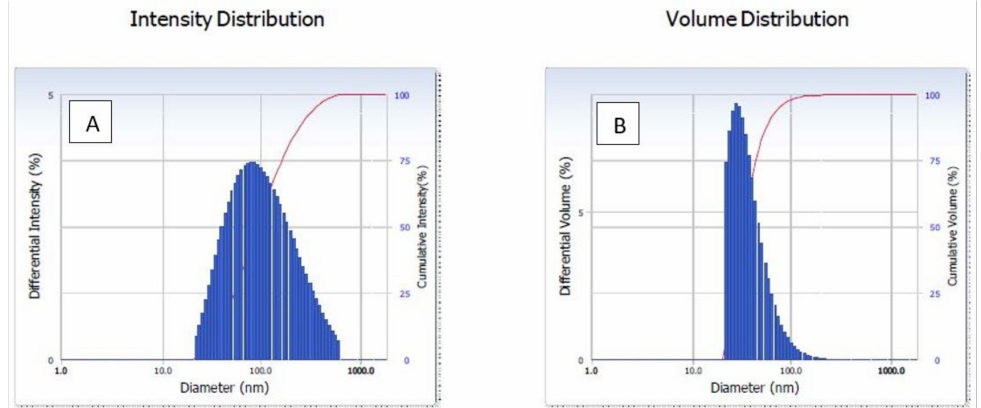
Figure 2. Dynamic light scattering (DLS) of green AgNPs. ( A ) Intensity, ( B ) volume distribution of green synthesized AgNPs.